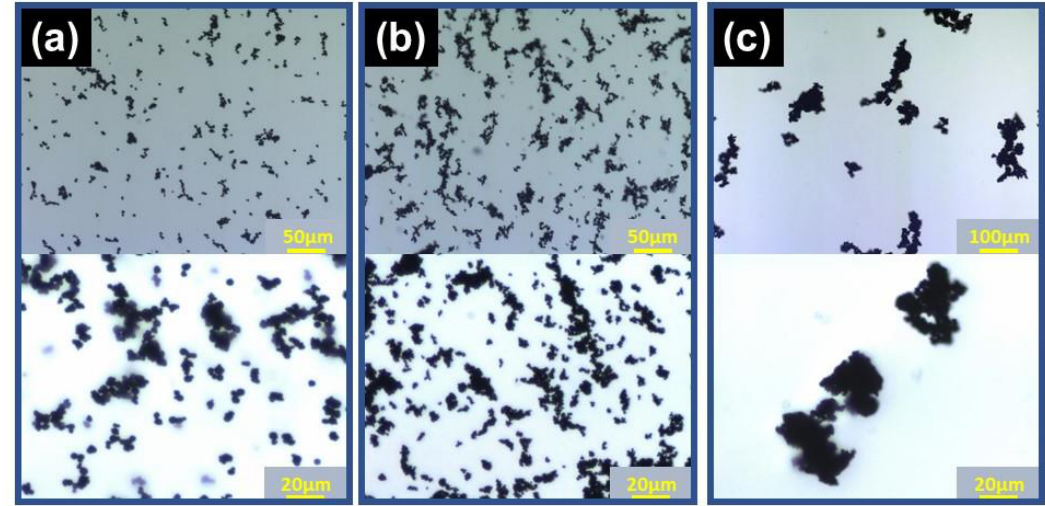
Figure 5. Microphotographs for magnetic particles in carrageenan hydrogels: ( a ) carbonyl iron, ( b ) iron oxide, and ( c ) barium ferrite particles ( Φ = 5 × 10 −3 , carrageenan concentration: 0.8 wt %).